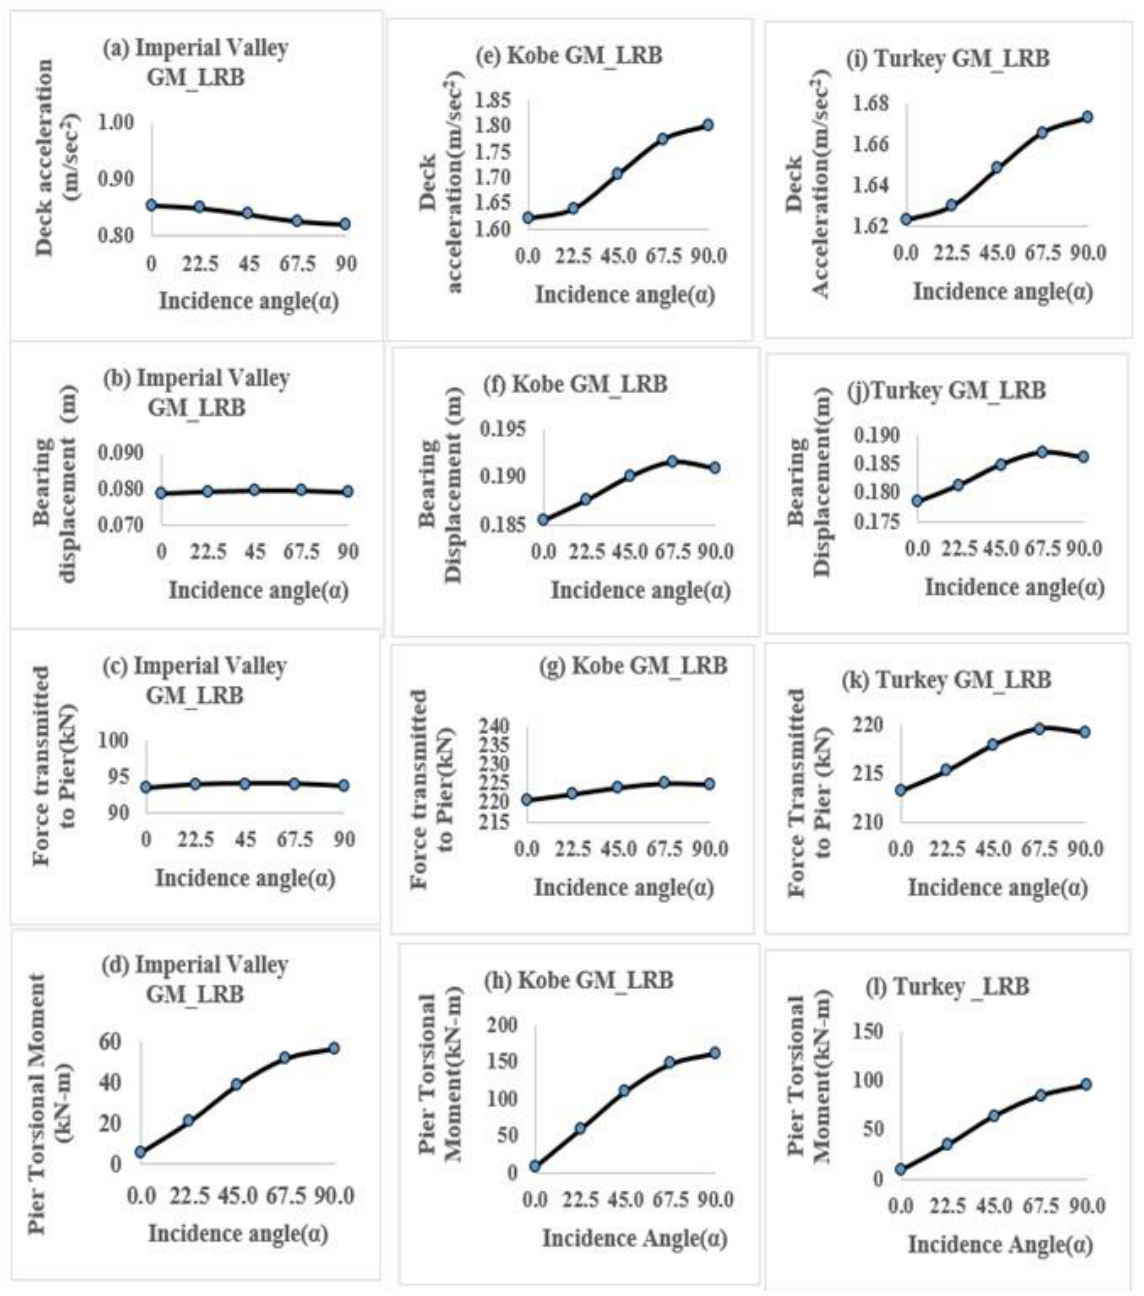
Figure 7. The bridge responses for uni-directional Imperial Valley ( a – d ), Kobe ( e – h ), and Turkey ( i – l ) Ground Motions with the variation of incidence angle.